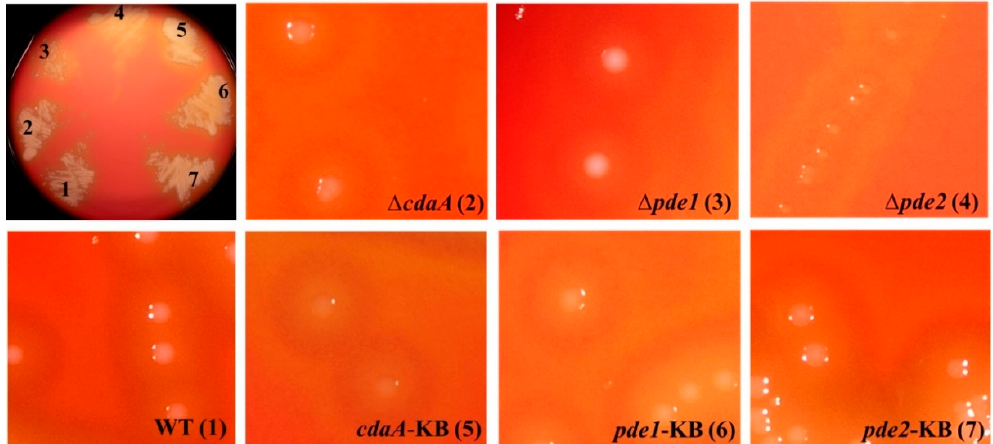
Figure 4. Transcription of genes related to c-di-AMP turn-over assessed by RT-qPCR. The gene encoding one of the subunits of DNA gyrase ( gyrA ) was used as reference gene. The relative transcription level of each gene in the mutants compared to the WT was calculated by the ΔΔ Cq- method. Shown are mean-values and standard error of the mean based on two independent experiments. * indicates statistical significance ( p < 0.05).